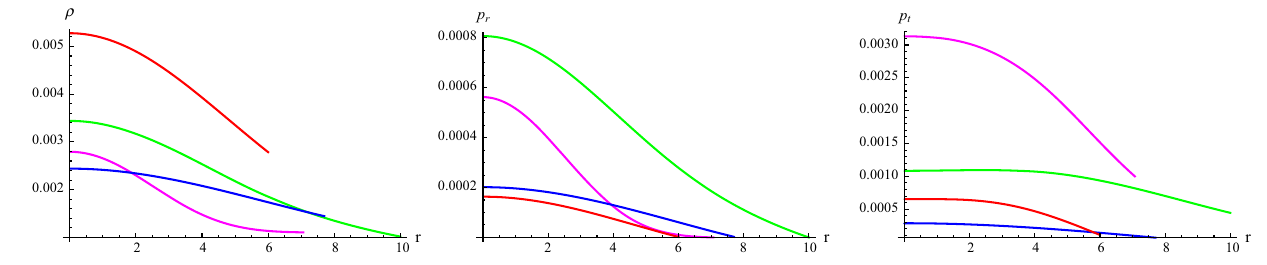
Fig. 1 Plots of energy density, radial pressure and transverse pressure versus r for different compact star